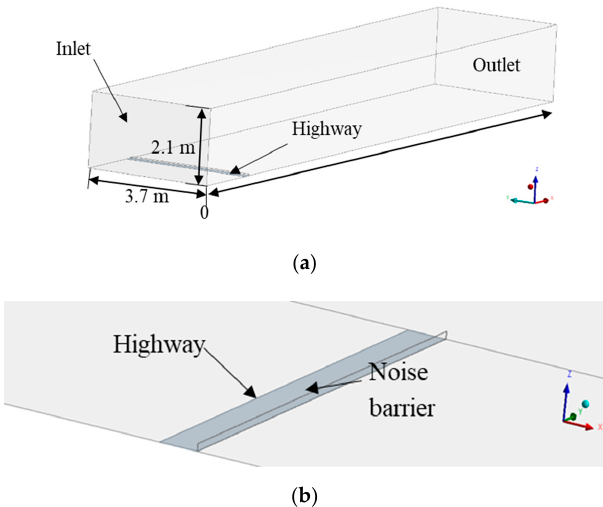
Figure 3. Computational domain (x-axis: Wind direction; y-axis: Highway extending direction; z-axis: Height). ( a ) Overall view; ( b ) close view of highway and noise